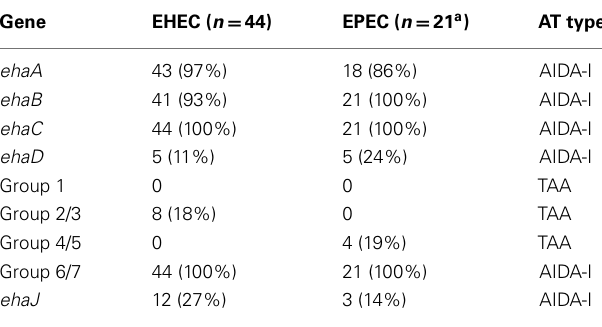
Table 1 | Prevalence ofAT-encoding genes in EHEC and EPEC.